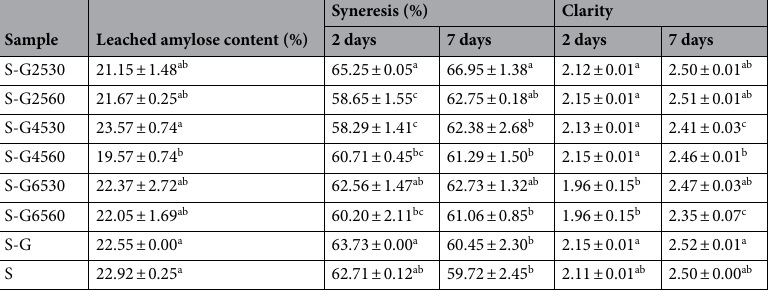
Table 1. Amylose content, syneresis, and paste clarity (after 2 and 7 days) of thermal-ultrasound treated corn starch-Arabic gum mixtures. a–c For each column, similar small code letters are not significantly different at p <